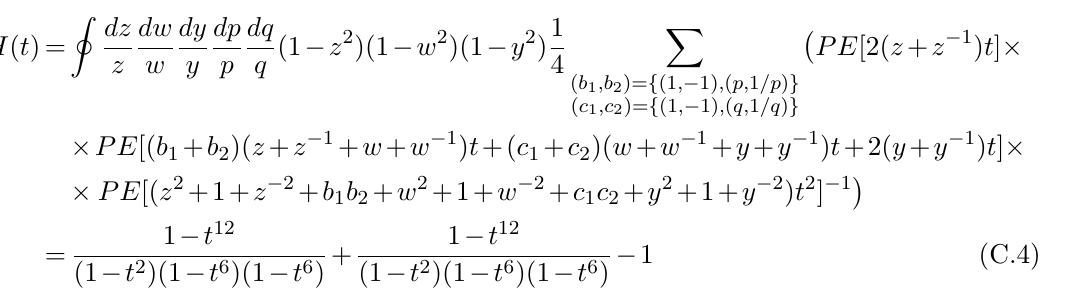
Figure 73. Quiver whose Coulomb branch is a D n subregular